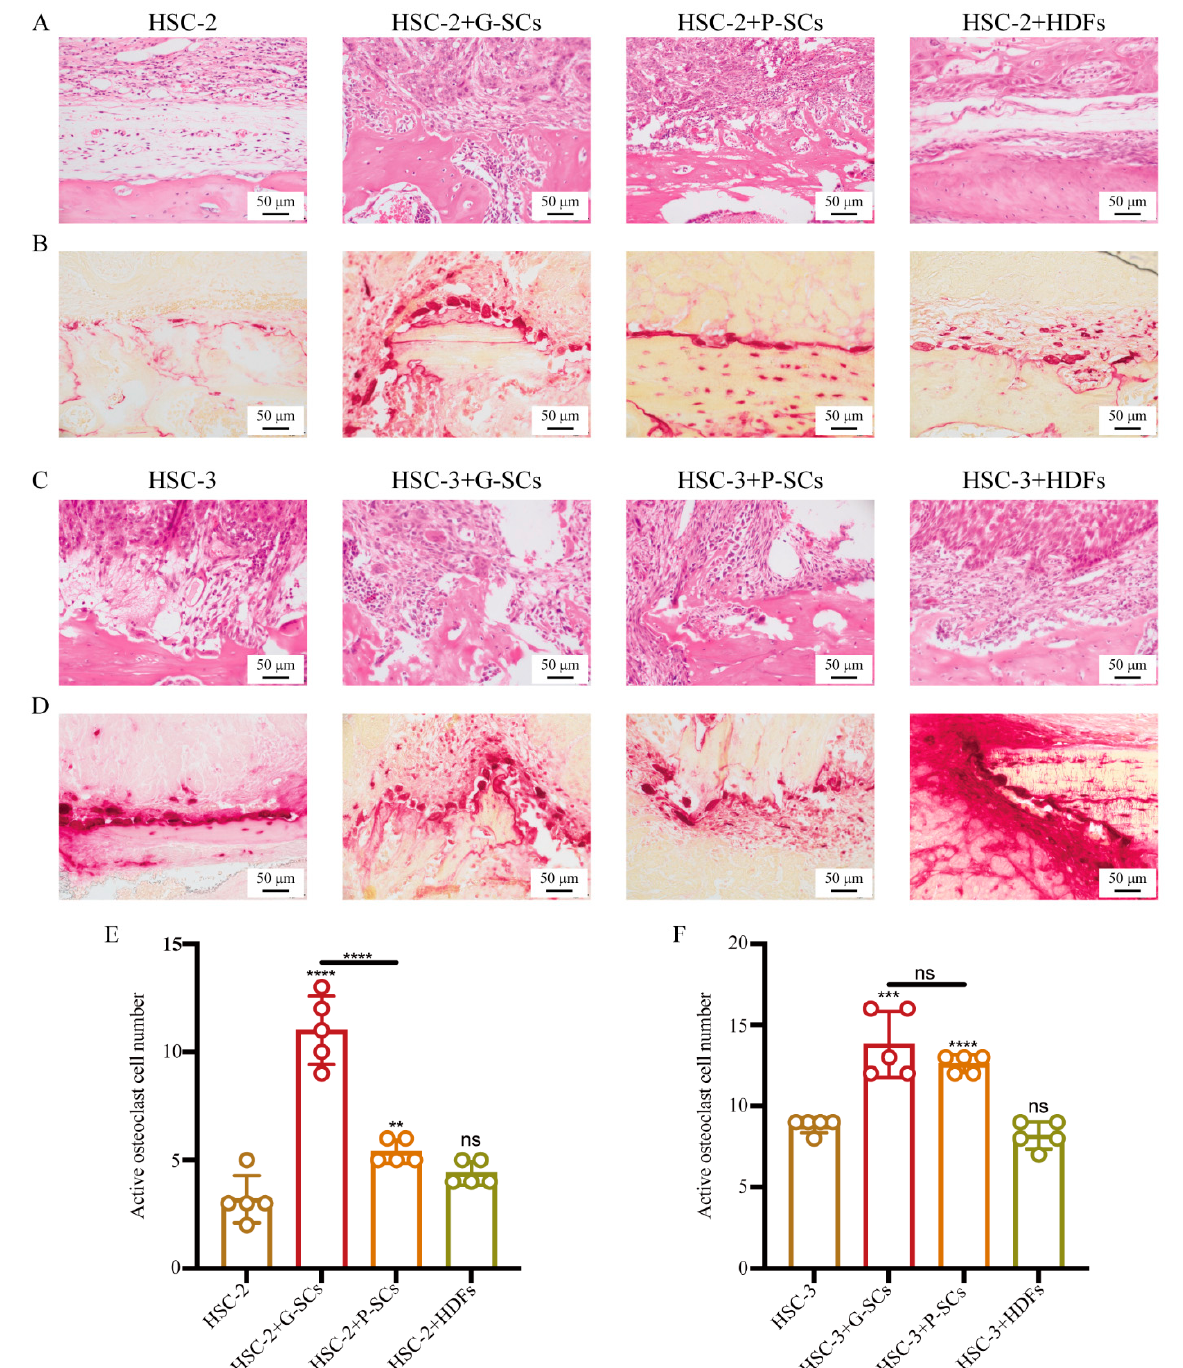
Figure 8. G-SCs and P-SCs promoted bone invasion by OSCC in vivo. ( A , C ) The effect of G-SCs and P-SCs on bone resorption of HSC-2 ( A ) and HSC-3 ( C ) in vivo was examined by HE staining. ( B , D ) The number of active multi-nucleated osteoclasts upon bone resorption was tested by TRAP staining to examine the effect of G-SCs and P-SCs on bone resorption of HSC-2 ( B ) and HSC-3 ( D ) in vivo. ( E , F ) Quantification of activated multi-nucleated osteoclast cell number in different groups of HSC-2 (E) and HSC-3 (F). Data are shown as the mean ± s.d. (s.d., standard deviation), n = 5. Each group compared with HSC-2 and HSC-3 group, respectively, and statistical analysis was performed by Student’s t -test, ns indicates p > 0.05, ** indicates p < 0.01, *** indicates p < 0.001, **** indicates p < 0.0001.